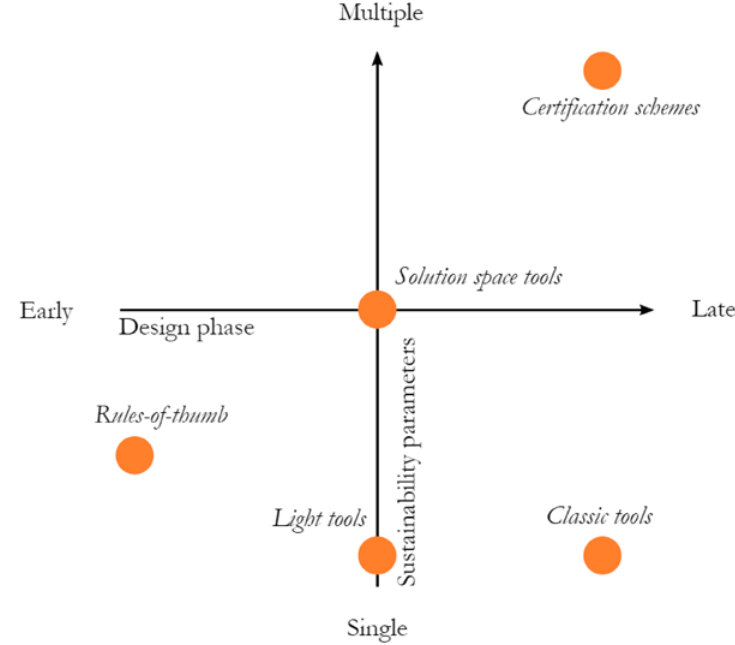
Tools used for decision support in sustainably oriented building